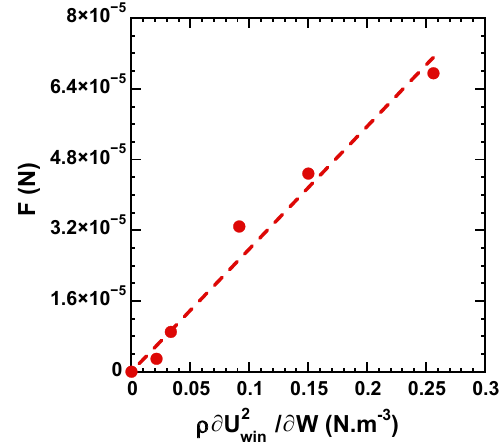
Figure 4. Experimentally measured force F versus ρ∂ U 2